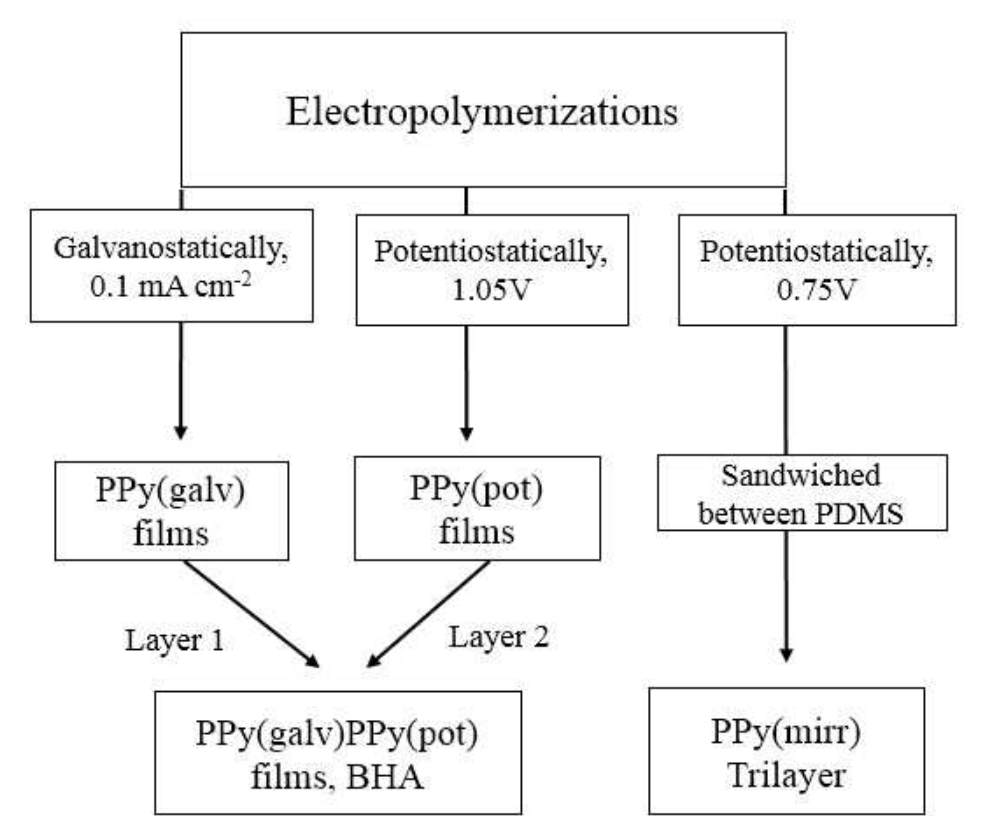
Figure 1. Flowchart of the fabrication of the various types of actuator materials, including pyrrole electropolymerization regimes.